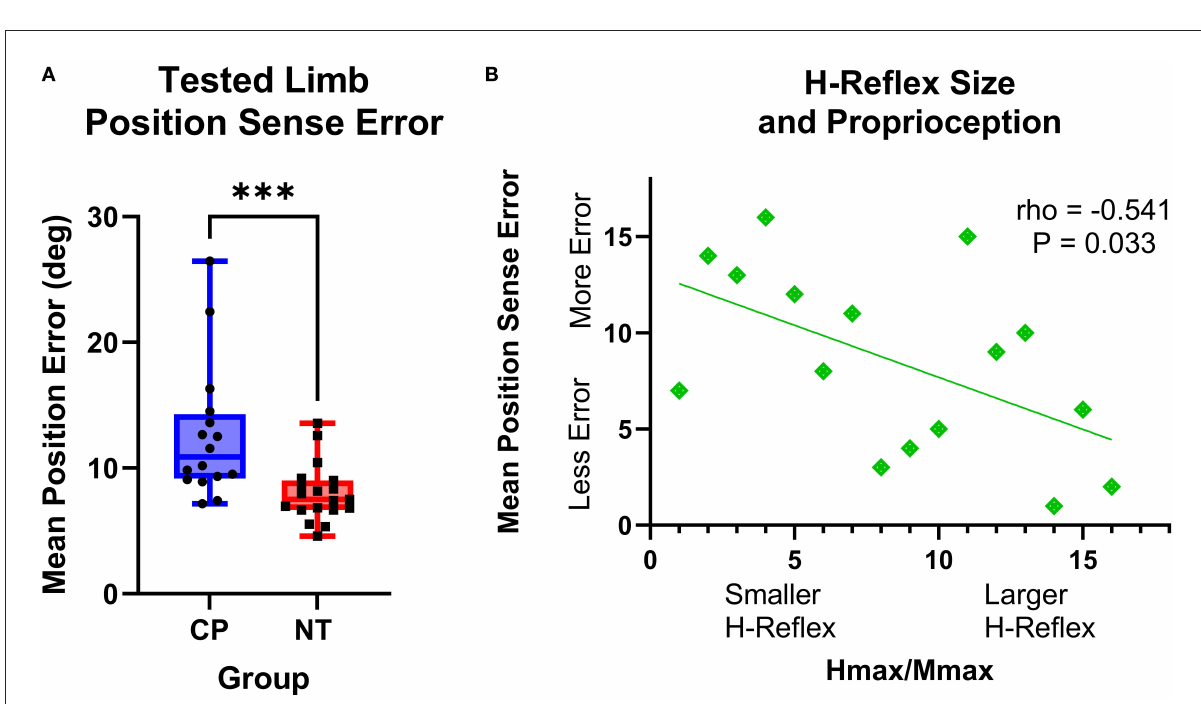
FIGURE5 The H-reflex size is related to position sense error in adults with cerebral palsy. (A) Box-and-whisker plots of the group mean position errors for the adults with cerebral palsy (CP) and neurotypical (NT) adult controls. As shown, the average position sense errors were significantly greater for the adults with CP. *** Indicates P < 0.001. (B) Rank-order correlation between the mean position sense error and H-reflex H:M ratios at rest for the adults with CP. As shown, there was a significant negative correlation between the strength of the H-reflex size (H:M ratio) and the